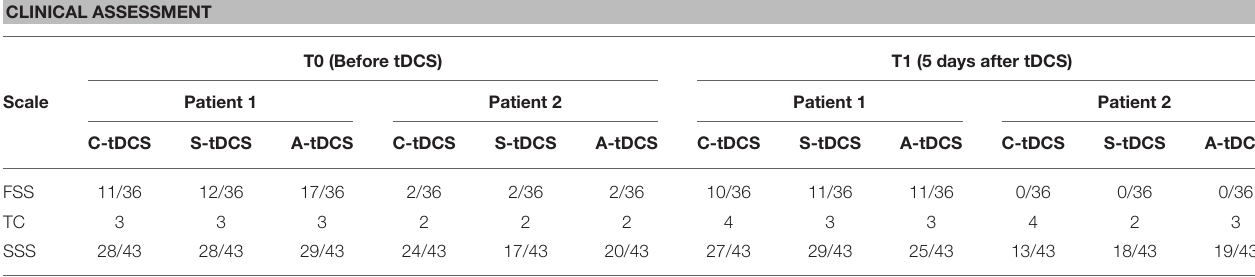
TABLE 2 | Clinical assessment of both patients before and after 5-days tDCS session. CLINICAL ASSESSMENT